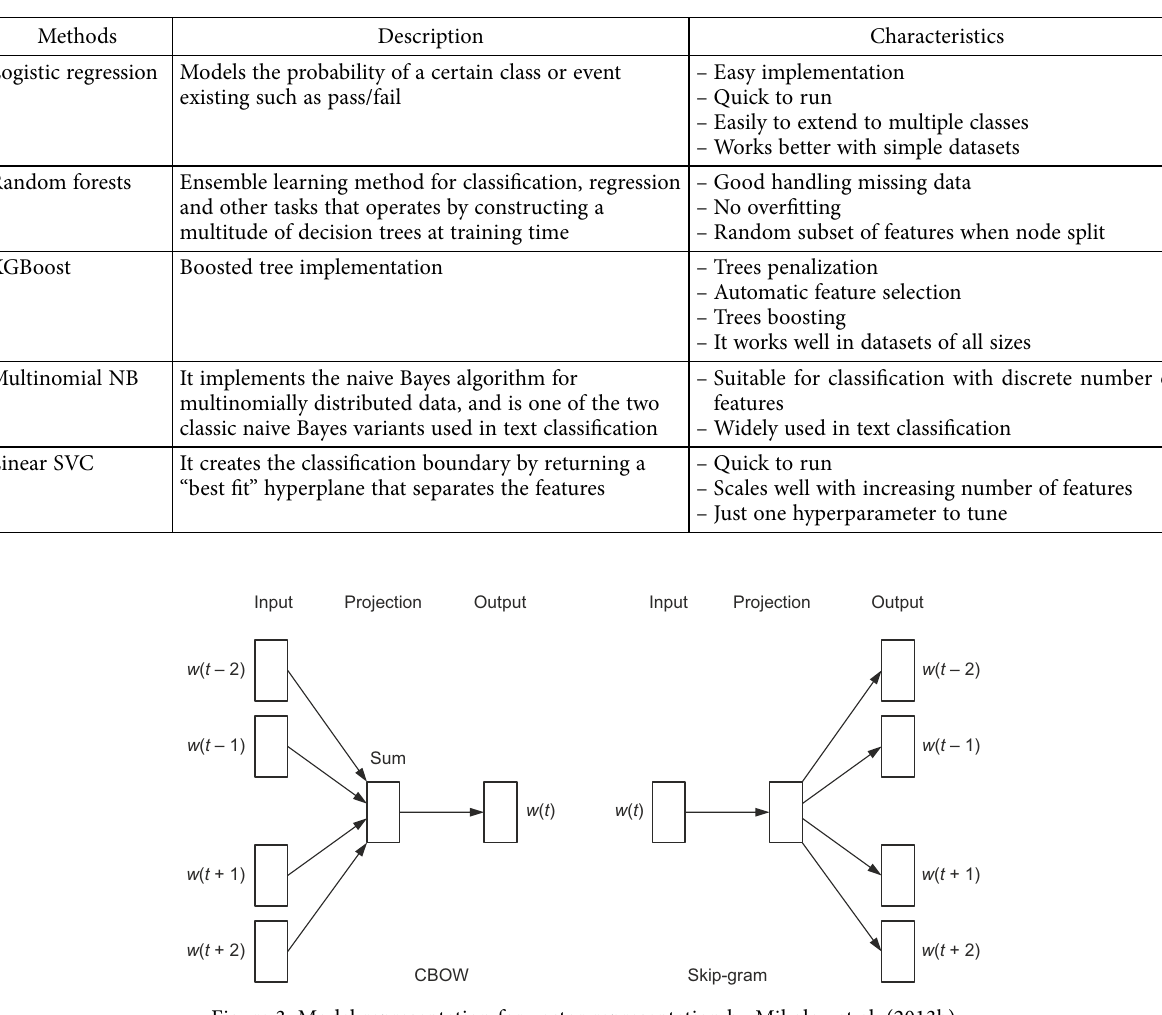
Table 1. Summary of considered text classification methodologies